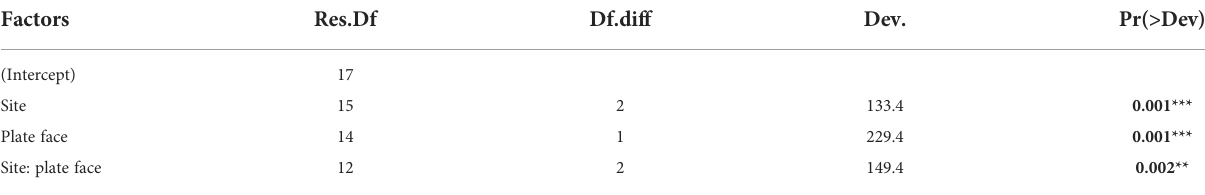
(Intercept) 17 Site 15 2 133.4 0.001*** Plate face 14 1 229.4 0.001*** Site: plate face 12 2 149.4 0.002** Res.Df, residual degrees offreedom; Df.diff, difference indegrees offreedom; Dev, deviance; and Pr(>Dev),p-value. Full model output coef fi cientscan be foundin Supplementary Table S9. Asterisks represent the level of signi fi cance of individual p-values (*when p<0.05, ** when p<0.01, *** when p<0.001). Values in bold represent signi fi cant test